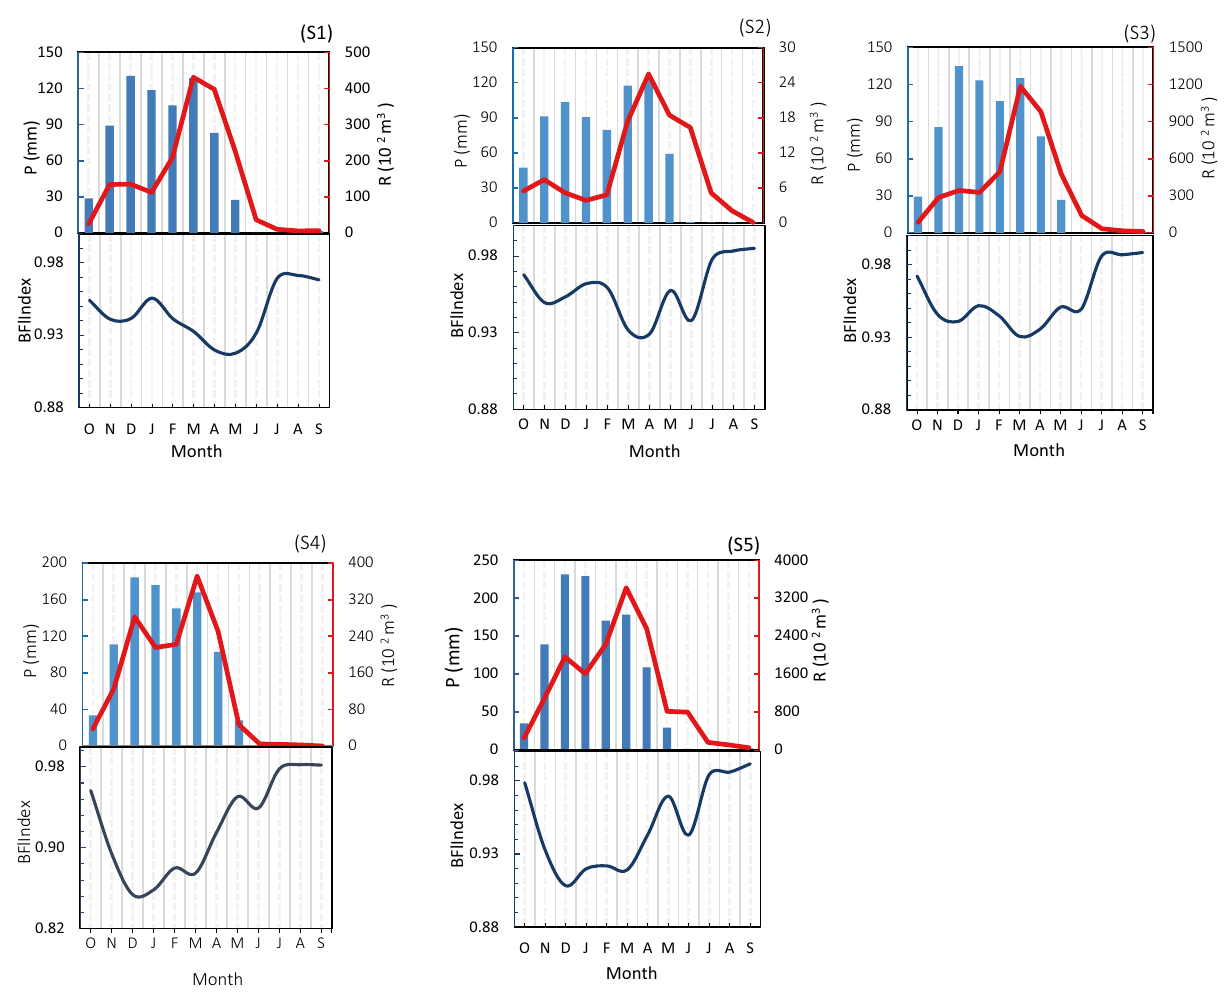
Figure 4. The monthly distribution of precipitation, runoff, and baseflow index in the sub-basins of the Dez